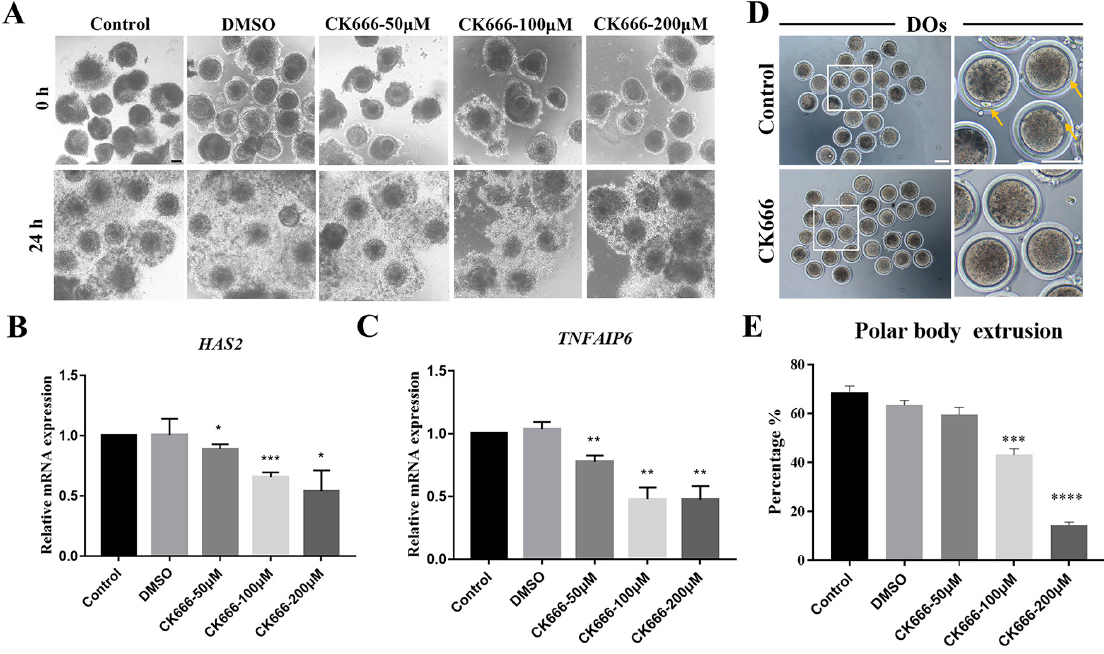
Figure 1. Inhibition of Arp2/3 complex affects goat oocyte maturation. ( A ) A selection of images depicting the expansion of cumulus clouds. Bar = 100 µ m. ( B , C ) The expression of genes associated with cumulus expansion was observed. *, p < 0.05; **, p < 0.01; ***, p < 0.001. ( D ) DIC images of oocytes from the control group and those exposed to CK666 for 24h show different results. Yellow arrow indicated PBI. Bar = 100 μ m. ( E ) The rate of polar body extrusion was compared between the control group and the CK666-exposed group after 24h of culture. ***, p < 0.001; ****, p < 0.0001.